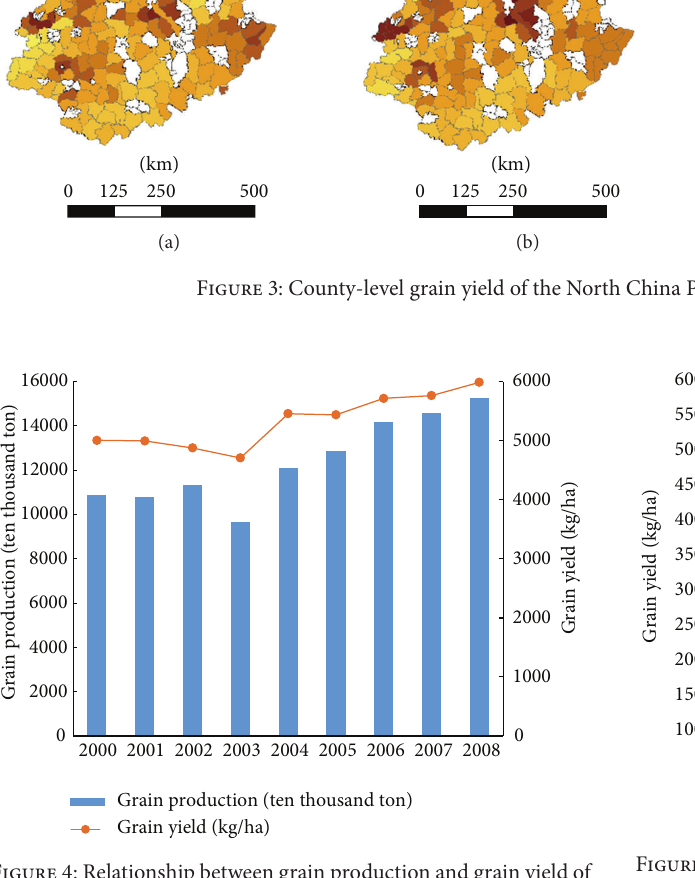
Figure 4: Relationship between grain production and grain yield of the North China Plain, 2000–2008.